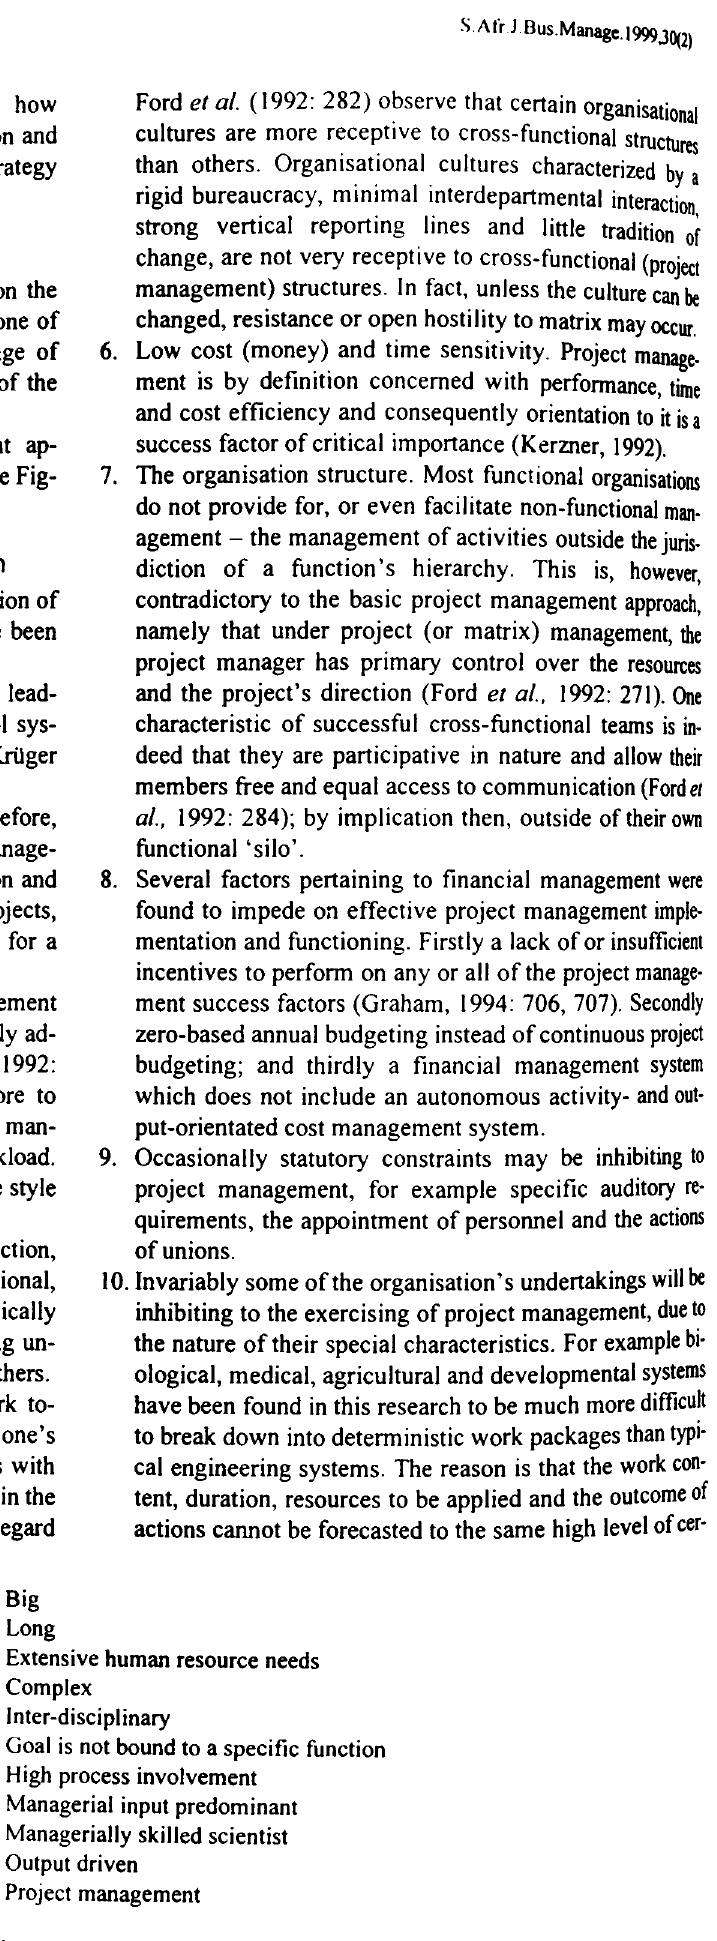
Figure 1 Continuum of project